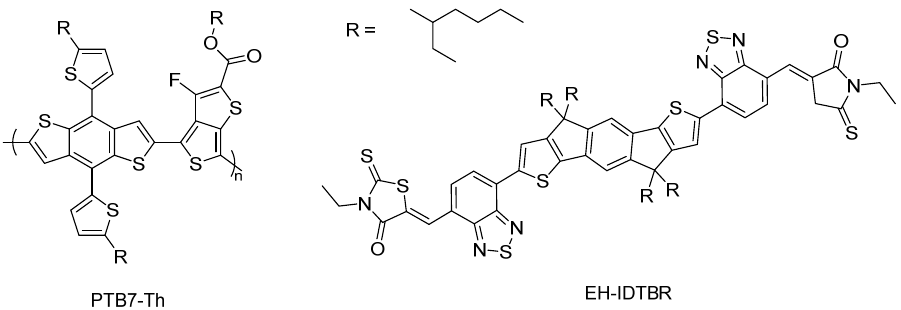
Figure 38. The structure of the donor (PTB7-Th) and the acceptor (EH-IDTBR) components used for the nanoparticle blends synthesized and tested for photocatalytic hydrogen production [30] .